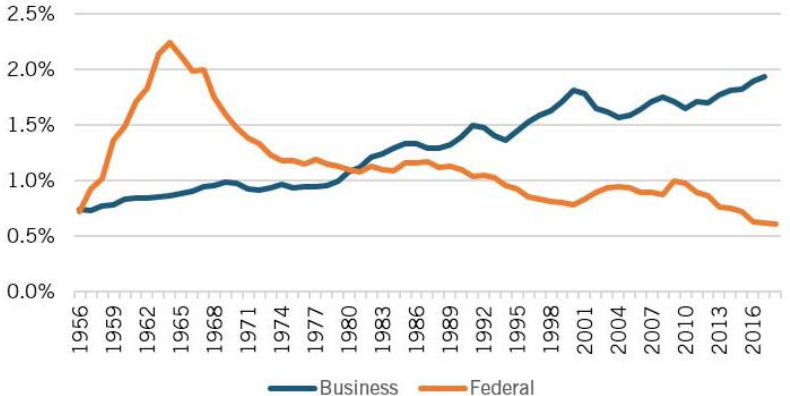
Figure 5. History of R&D Expenditure in the US by business and government